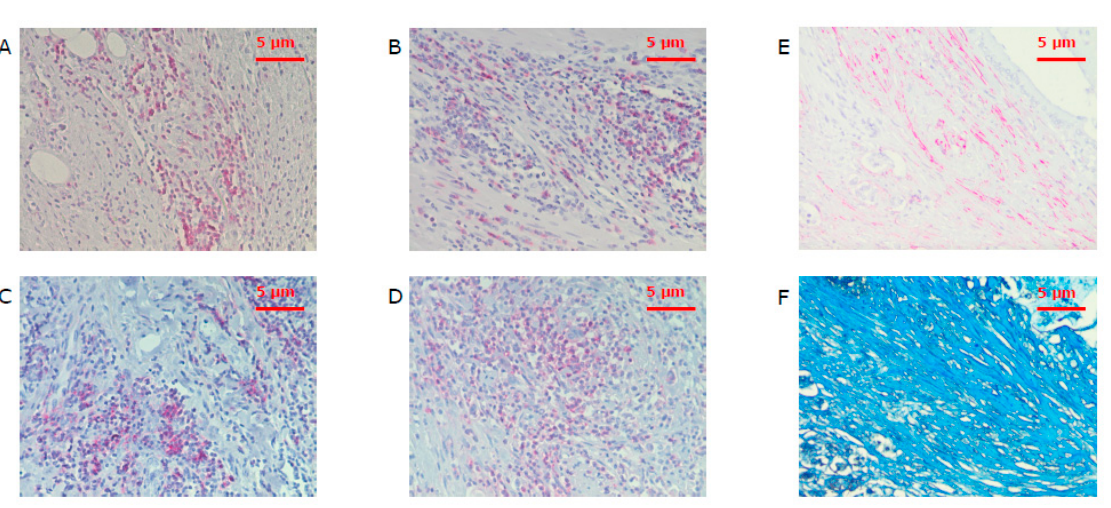
Figure 5. Hot spots with tumor-infiltrating leukocytes of CD3 + ( A ), CD8 + ( B ), CD20 + ( C ), and CD66b + ( D ) cells under a power field of 200 × magnification as well as corresponding areas of α -sma ( E ) and collagen ( F ) stained spots. CD3 is the marker of T cells, CD8—of cytotoxic T cells, CD20—of B cells, CD66b—of neutrophils, and α -sma—of cancer associated